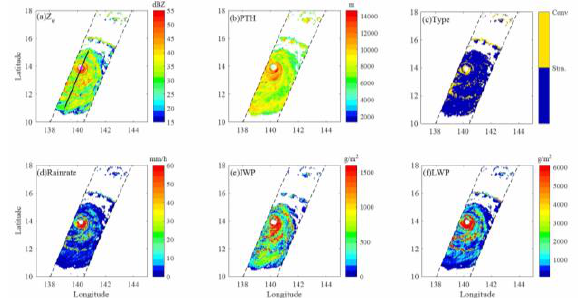
Figure 1. (a)-(f) represent the physical parameters of “Mangkhut” detected by the GPM DPR: Corrected radar reflectivity factor, Precipitation top height, Rainfall type, Near-surface rainfall rate, Ice water path (IWC), and Liquid water path (LWC). The black dotted line in Figures 1a-f is the boundary of the GPM DPR KuPR observation range, and the “*” indicates the position of the centre of the typhoon eye.